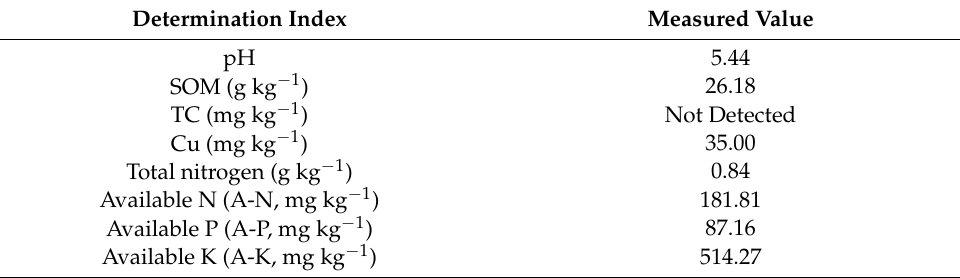
Table 1. Physical and chemical properties of test soils.